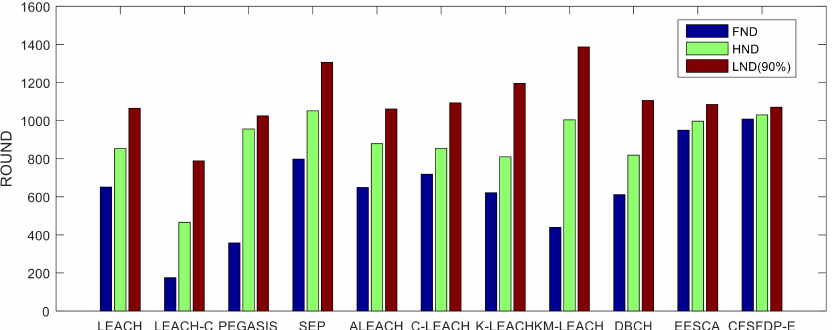
Figure 9. Network lifetime comparison of LEACH, LEACH-C, SEP, ALEACH, C-LEACH, K-LEACH, KM-LEACH, DBCH, EESCA, and